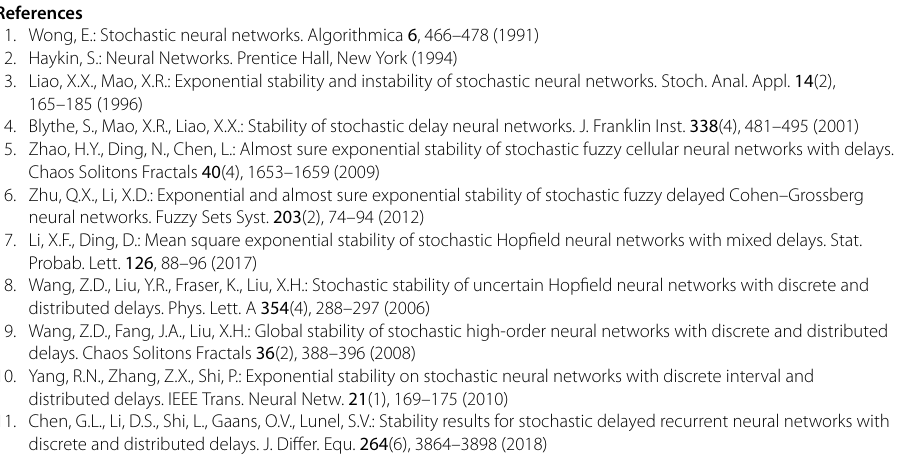
( t ) of system (4.1) with U K l